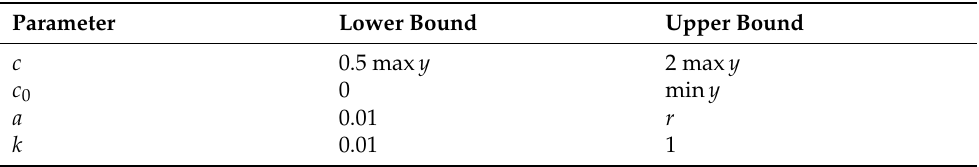
Table 1. Values of the lower and upper bounds for each parameter. The variable y refers to the recorded data of γ ( h ) . The lower bound of parameter c changes to zero when using Equations (2) and (4).